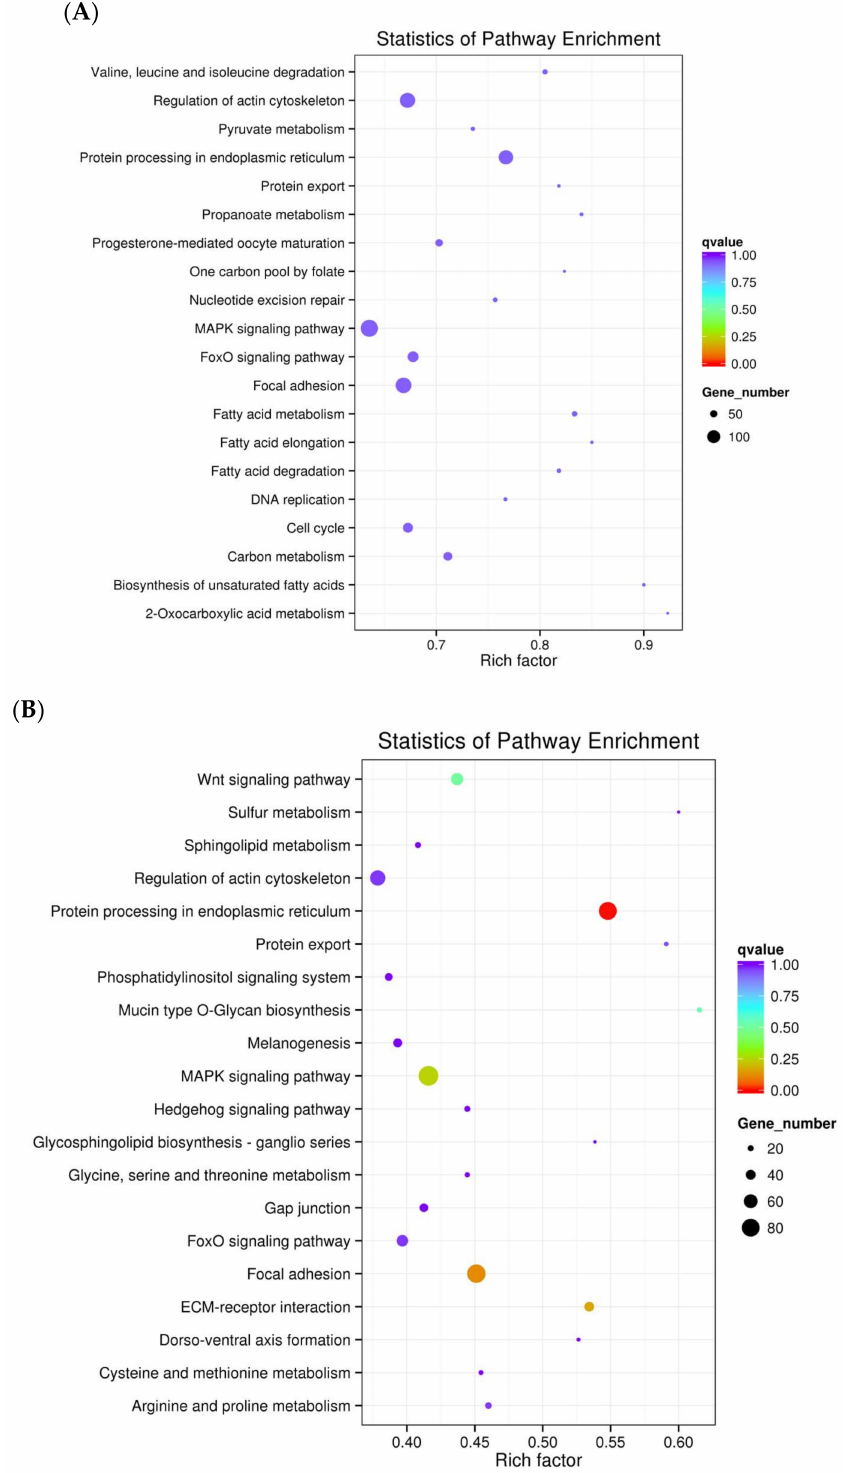
Figure 3. Kyoto Encyclopedia of Genes and Genomes (KEGG) annotation for differentially expressed genes. ( A ) KEGG analyses based on differentially expressed genes in Herts/33 relative to controls; and, ( B ) KEGG analyses based on differentially expressed genes in LaSota relative to controls. Circles indicate numbers of genes and colors depict the richness